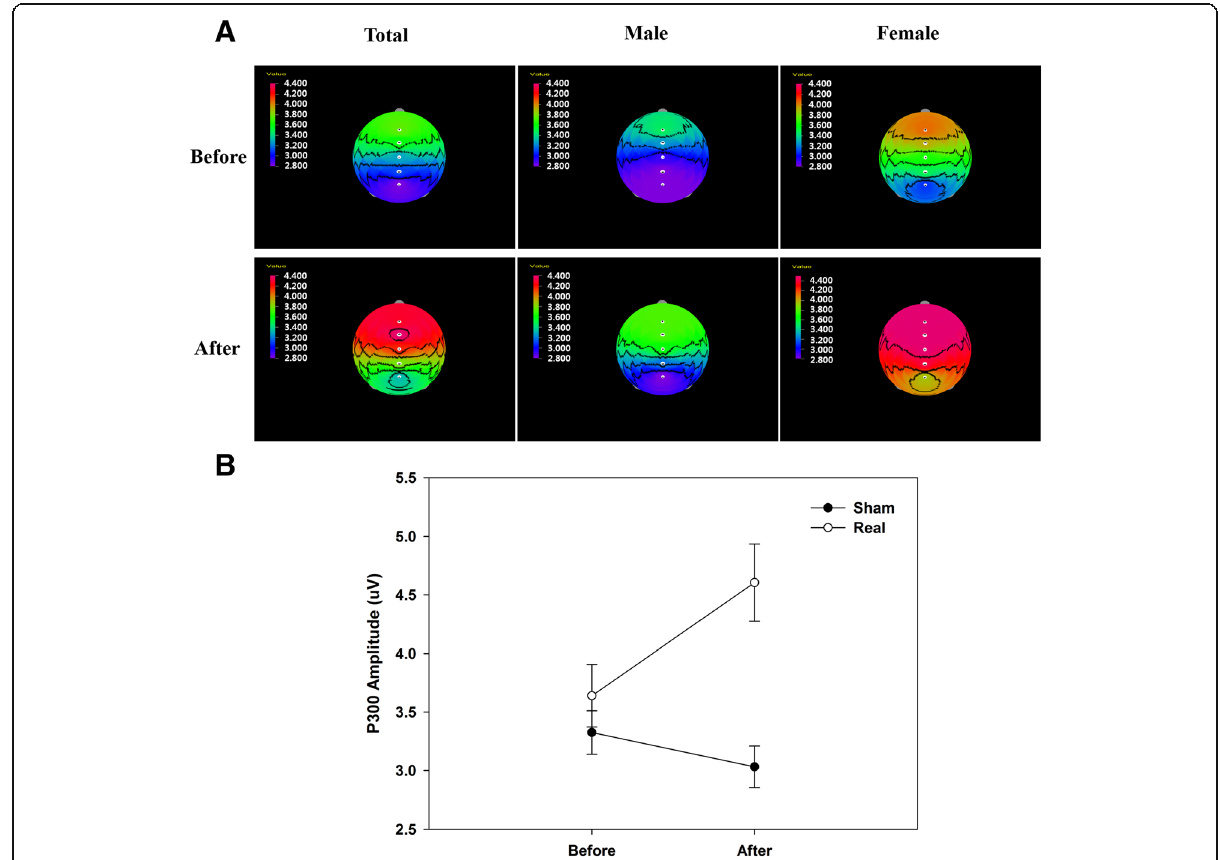
Fig. 3 P300 amplitude change after electrical stimulation. a ERP topographical maps showing (the differences in) the P300 amplitude obtained from the male and female subjects before and after electrical stimulation. Power was found to increase around the parietal lobe after stimulation in both the female and male groups. In particular, changes around the frontal lobe and parietal lobe were more significant in the female group than in the male group. b Total P300 amplitude difference in the females. The results from five channels were averaged, demonstrating the differences in the P300 amplitude before and after the low-frequency electrical stimulation. In the Real group, the amplitude was significantly increased compared to that of the Sham group